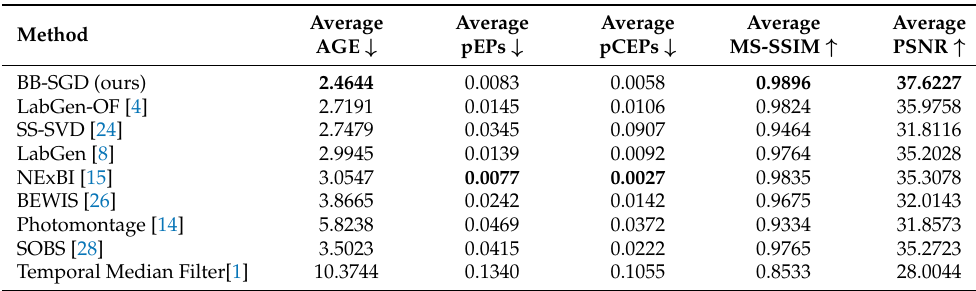
Table 3. Evaluation results per criteria on the SBI dataset. ↓ indicates lower score is better, ↑ indicates higher score is